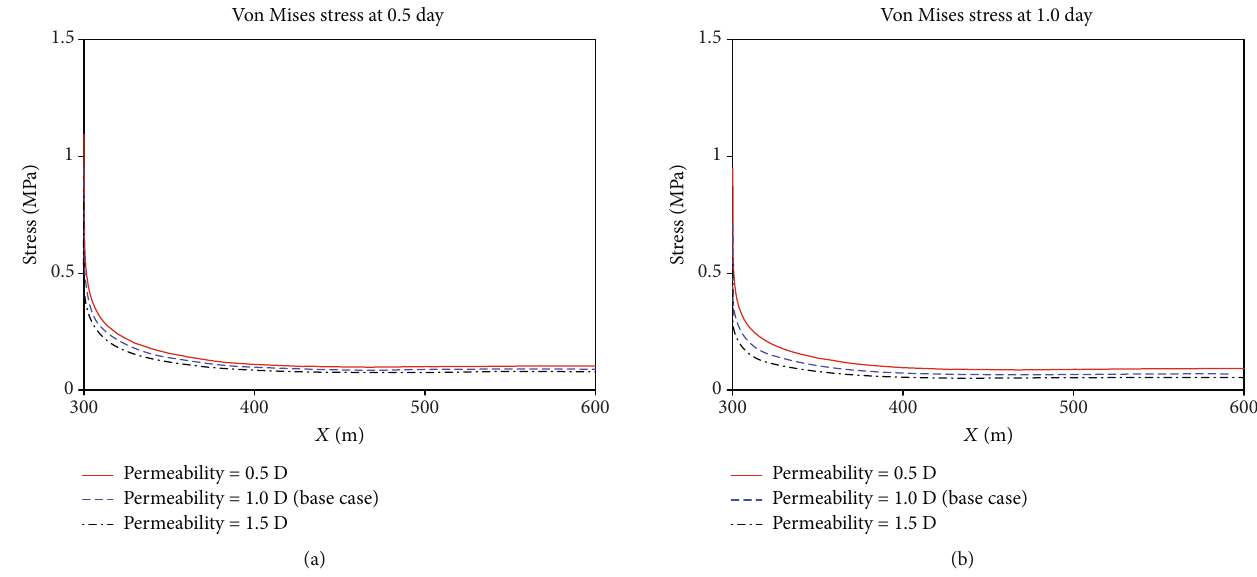
Figure 10: 1D stress distribution from the wellbore to the domain boundary along Y = 300 m after (a) 0.5 day and (b) 1 day of shallow water fl ow for permeability sensitivity.